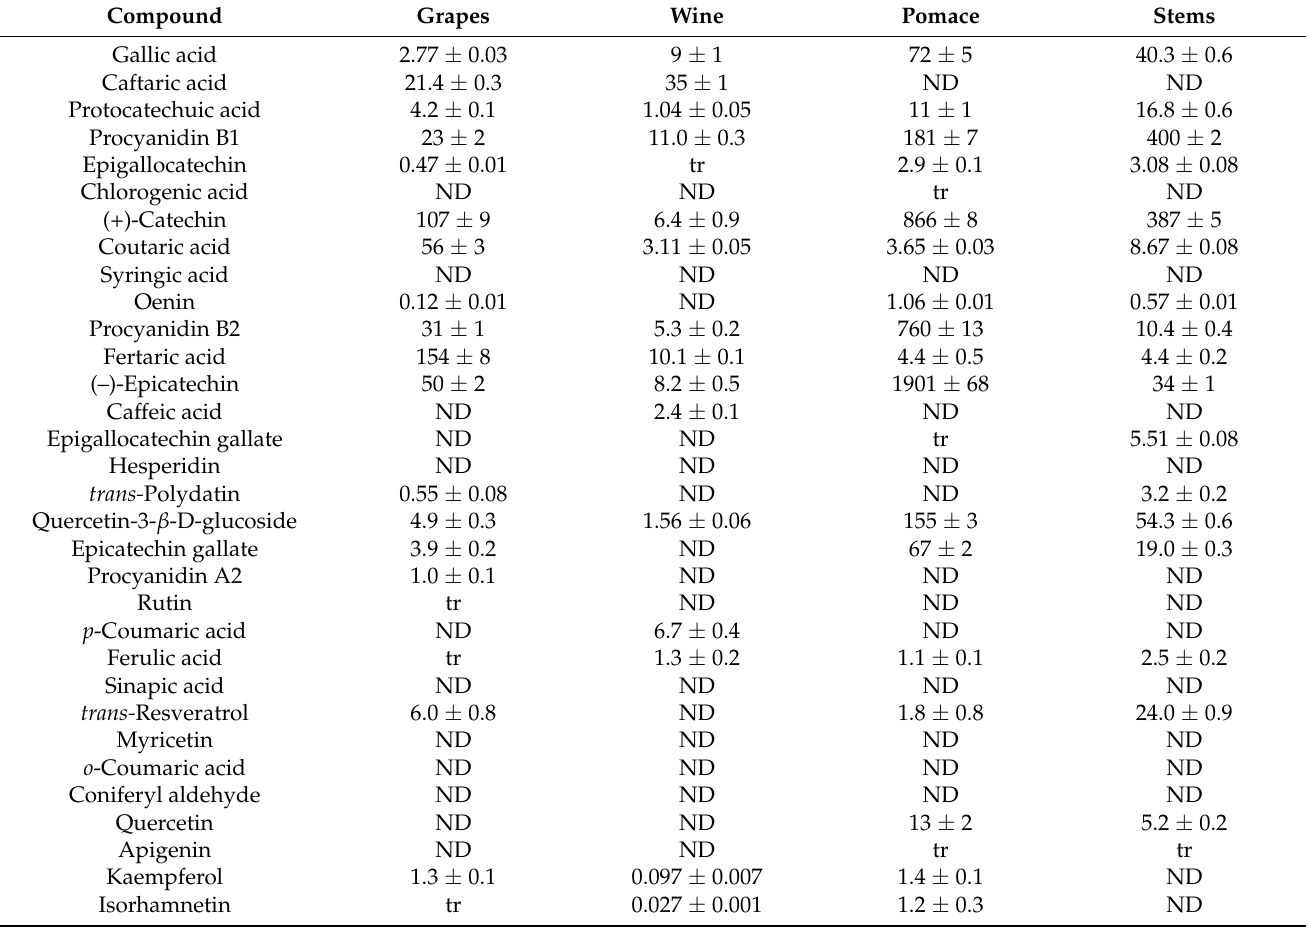
Table 7. Quantitation of phenolic compound content in the Monemvassia white variety (mg/kg DW) and wine